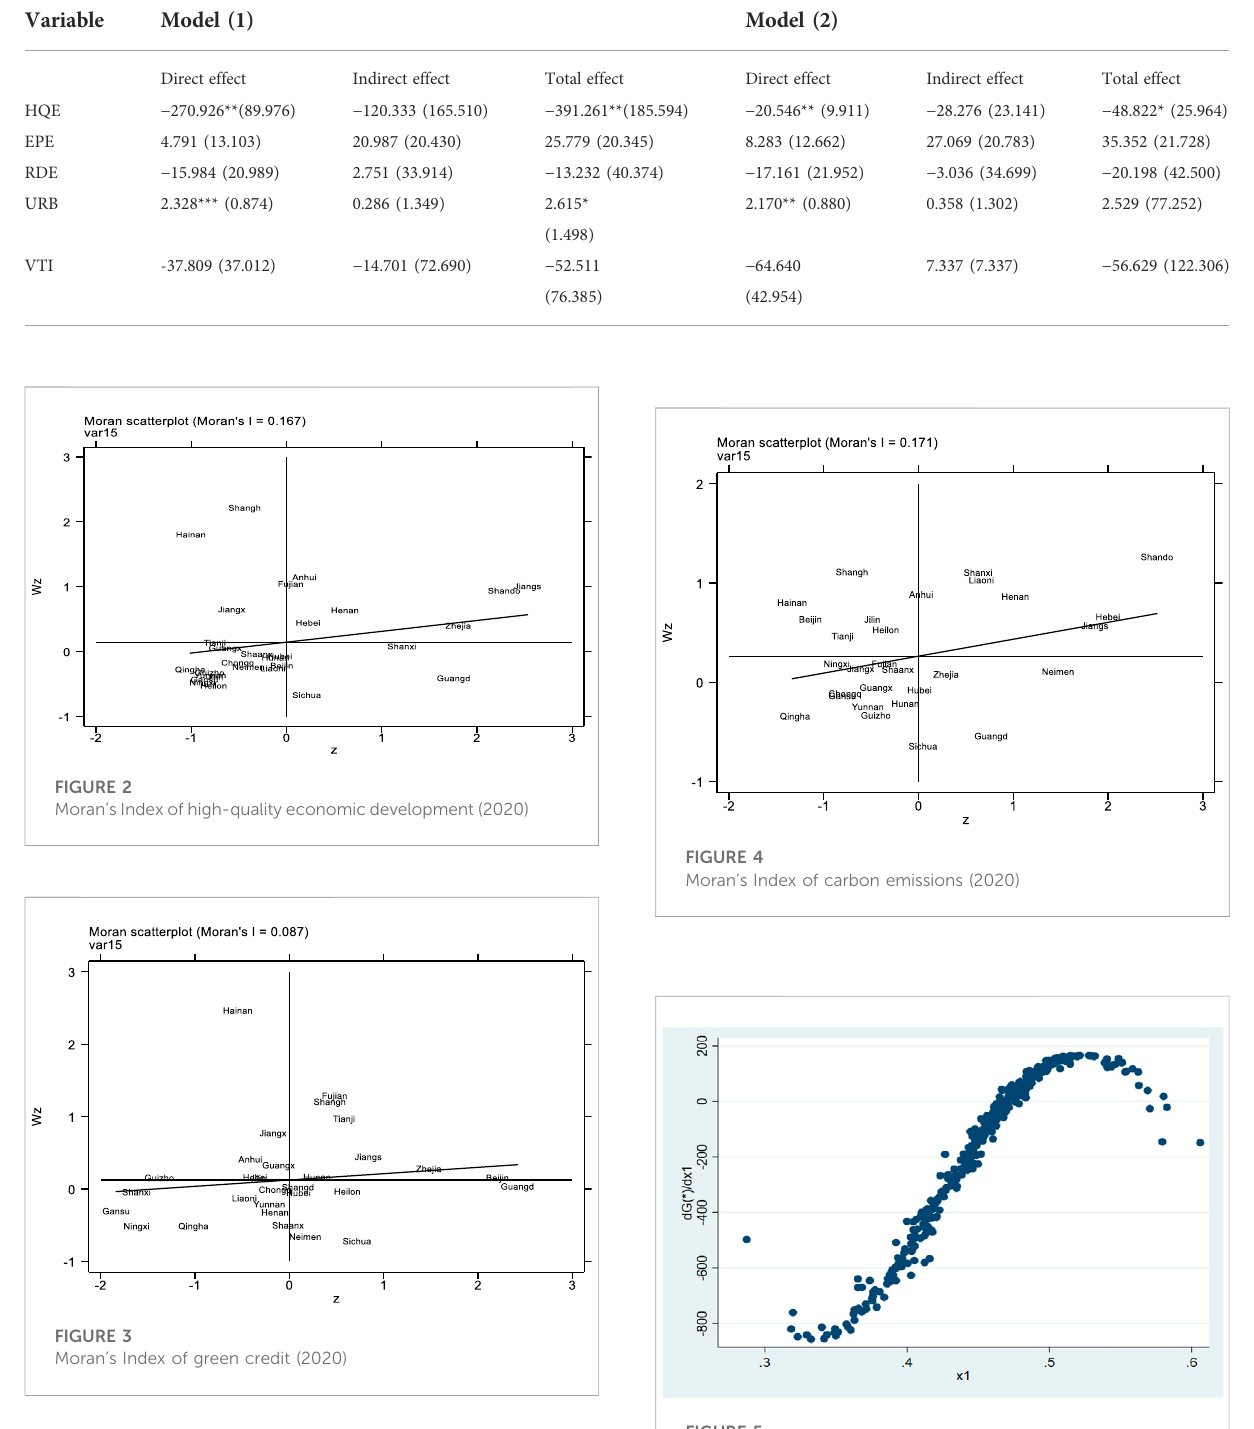
FIGURE 5 Partial plot of in fl uence of high-quality economic development on carbon